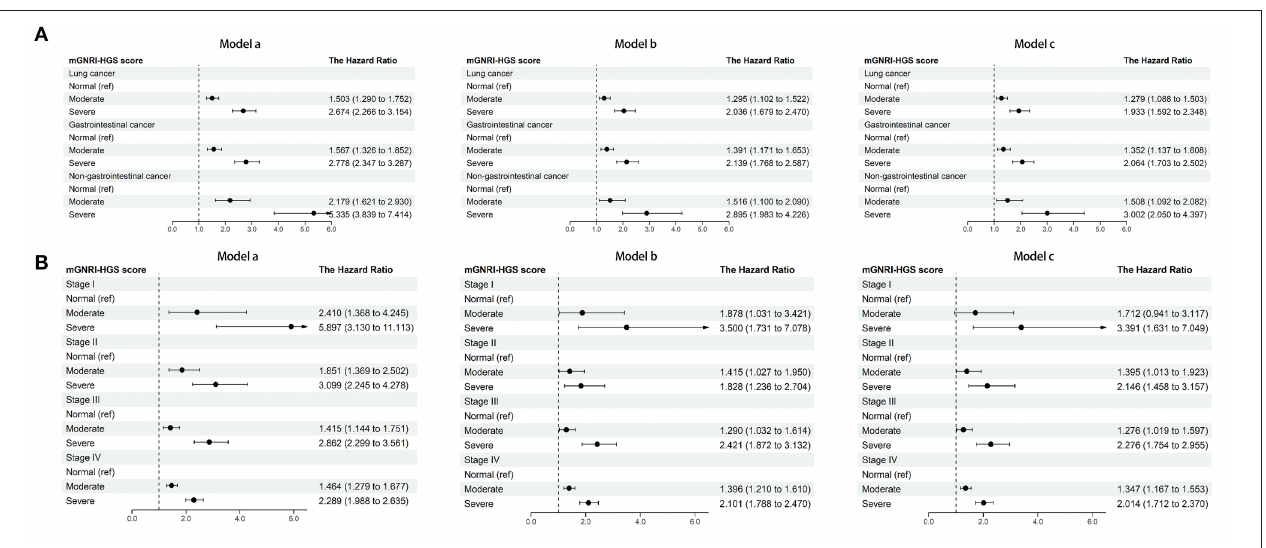
FIGURE 2 | Dose-response effects of mGNRI-HGS score based on subgroup. (A) , tumor types; (B) , pathological stages. Model a, No adjusted. Model b, Adjusted for age, sex, BMI, TNM stage. Model c, Adjusted for age, sex, BMI, TNM stage, tumor type, surgery, radiotherapy, chemotherapy, hypertension, diabetes, smoking, drinking, family